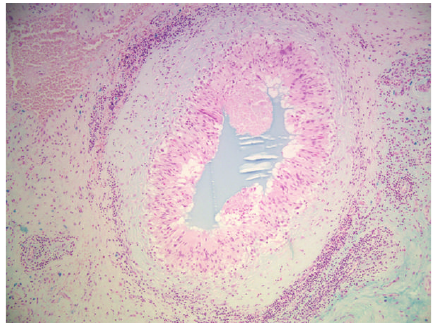
Figure 3: Alcian blue stain of central material consistent with previously injected Hylan G-F 20.